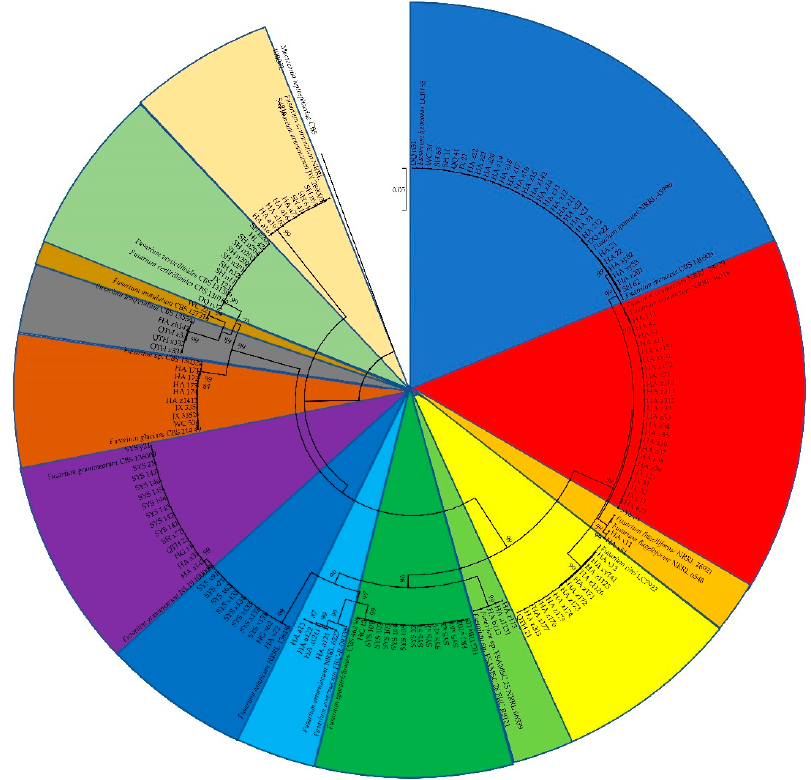
Figure 3. Phylogenetic tree obtained from maximum likelihood analysis based on the concatenated sequences of tef1 and rpb2 genes. Support values at nodes representing RA × ML bootstrap percentages with values ≥ 70 are shown above the branches.